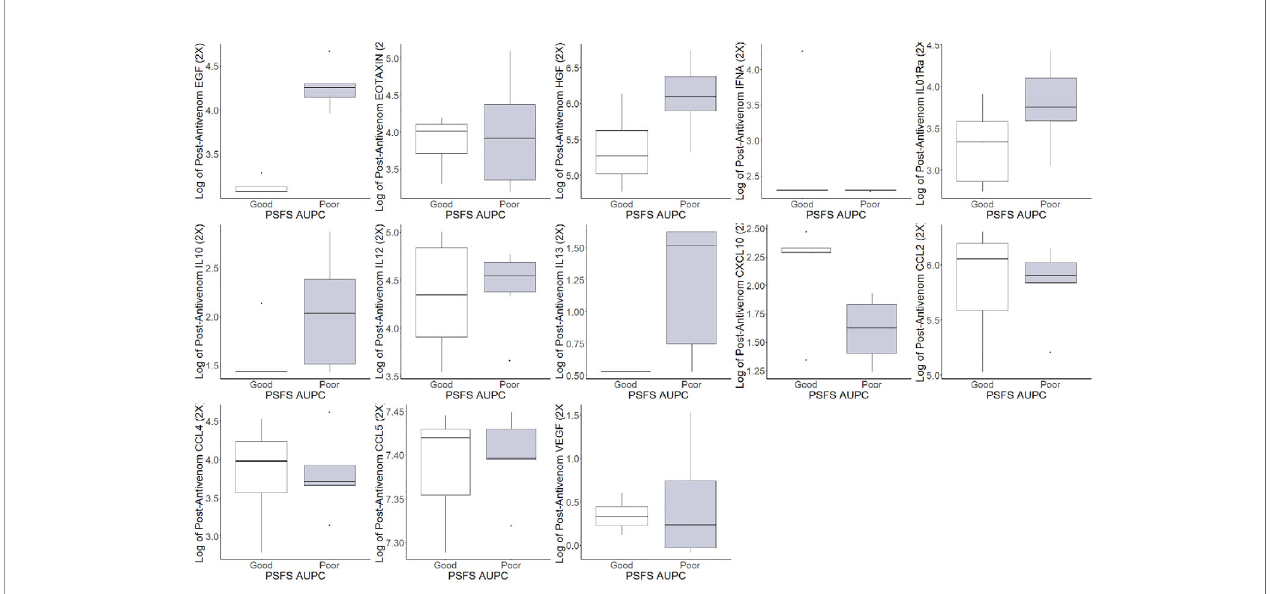
FIGURE 4 | Post-antivenom cytokine and chemokine values of patients with good and poor recovery. *EGF: endothelial growth factor, EOTAXIN: eosinophil chemotactic proteins, *HGF: hepatocyte growth factor, IFNA: interferon alpha, *IL01RA: Interleukin 1 receptor antagonist, IL10: interleukin 10, *IL12: interleukin 12, IL13: interleukin 13, *CXCL10: C-X-C motif ligand 10, *CCL2: C-C motif ligand 2, *CCL4: C-C motif ligand 4, CCL5: C-C motif ligand 5, VEGF: vascular endothelial growth factor. *Difference in populations based on box